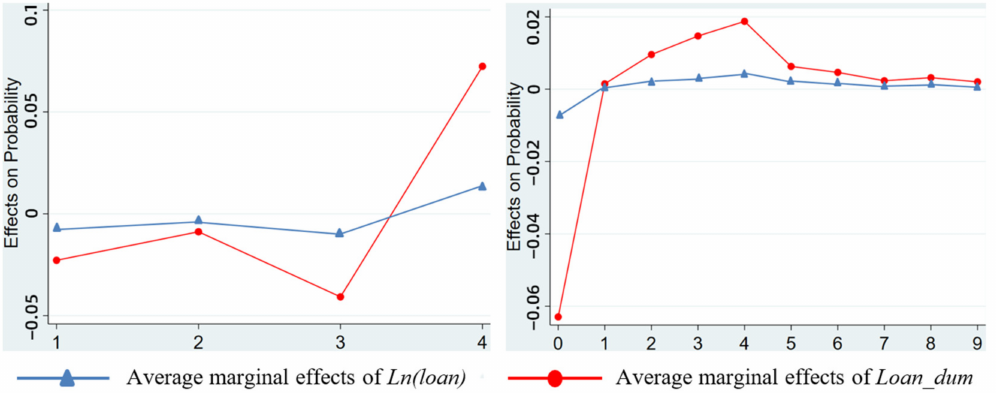
Figure 2. Average marginal effects of microfinance variables and trends with health level ( left ) or health insurance demand ( right ).